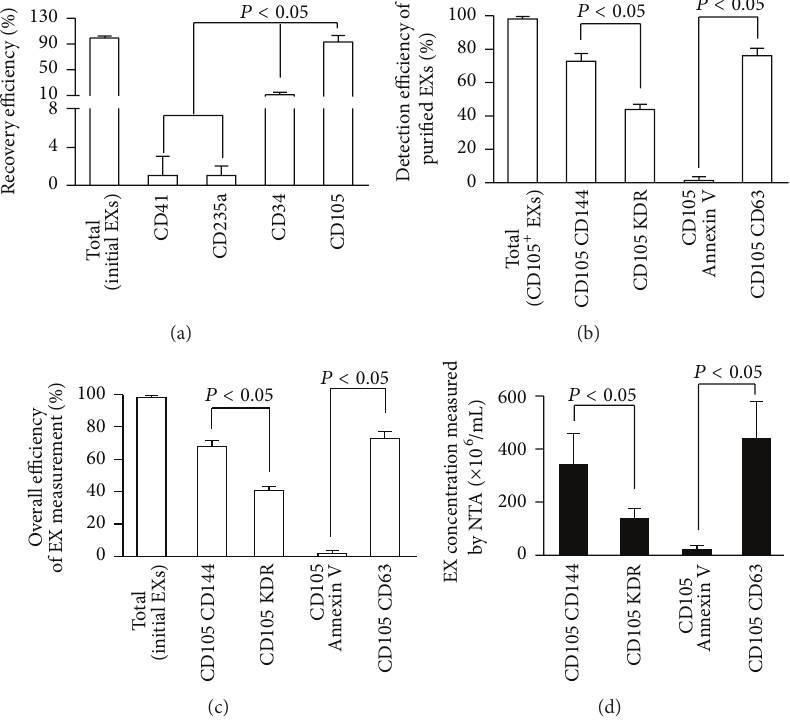
Figure 4: High recovery and detection efficiency of EC-EXs from particle-free plasma by using microbead purification and fluorescence NTA detection methods. (a) EC-EXs were recovered from particle-free plasma by using microbeads conjugated with various antibodies and analyzed by NTA. (b) The detection efficiency of recovered CD105 + EXs that were labeled with secondary antibodies (CD144, or KDR, or Annexin V, or CD63) conjugated with Q-dots and analyzed by fluorescent NTA. (c) The overall efficiency for measuring the recovered CD105 + EXs colabeled with CD144-, or KDR-, or Annexin V-, or CD63-conjugated Q-dots. (d) The absolute number of recovered CD105 + EXs